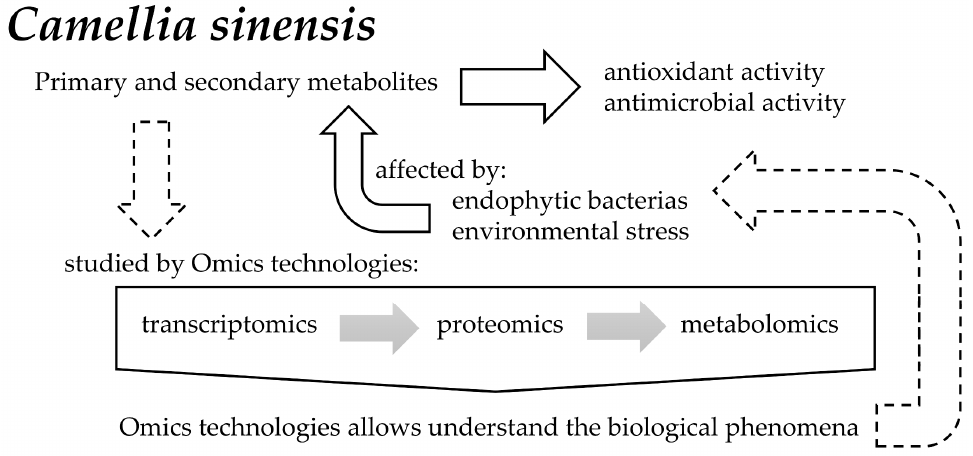
Figure 2. Role of endophytic bacteria and environmental stress on primary and secondary metabolites that affect antioxidant and antimicrobial activities of Camellia sinensis , and how omics technologies allow understanding of these biological phenomena.